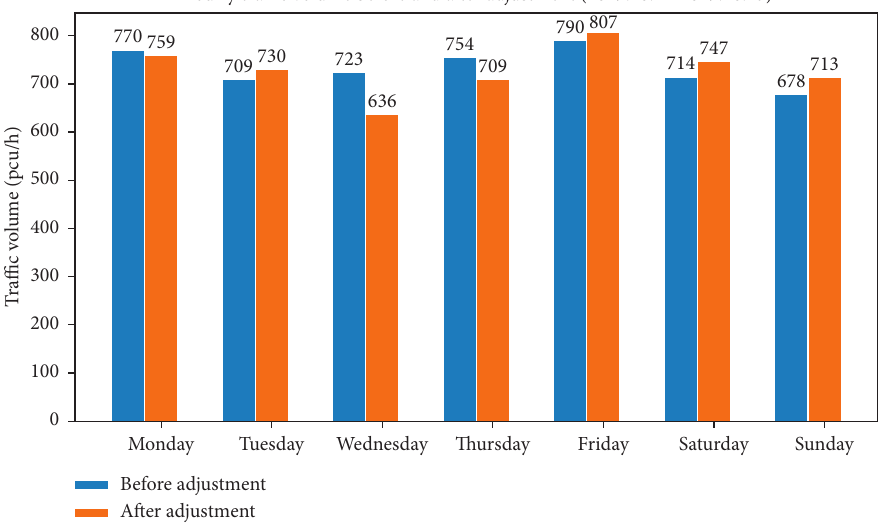
Figure 14: Traffic volume before and after adjustment in link